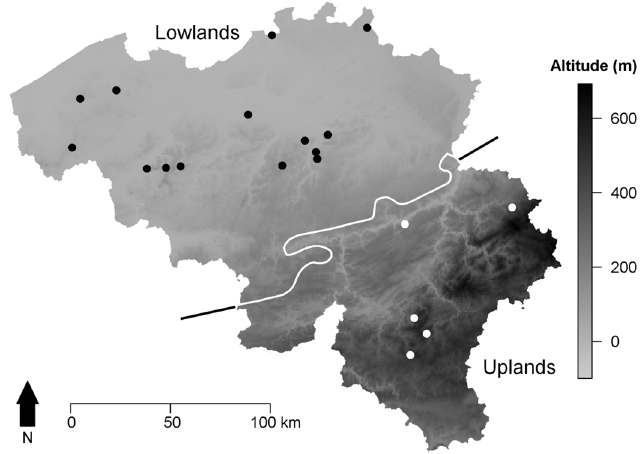
Figure 1. Locations of the selected beech forests in the lowlands ( black dots) and in the uplands ( white dots) in Belgium. Darker grey indicates higher elevation (m). The white line indicates the boundary between the two ecoregions (lowlands in the North and uplands in the South).